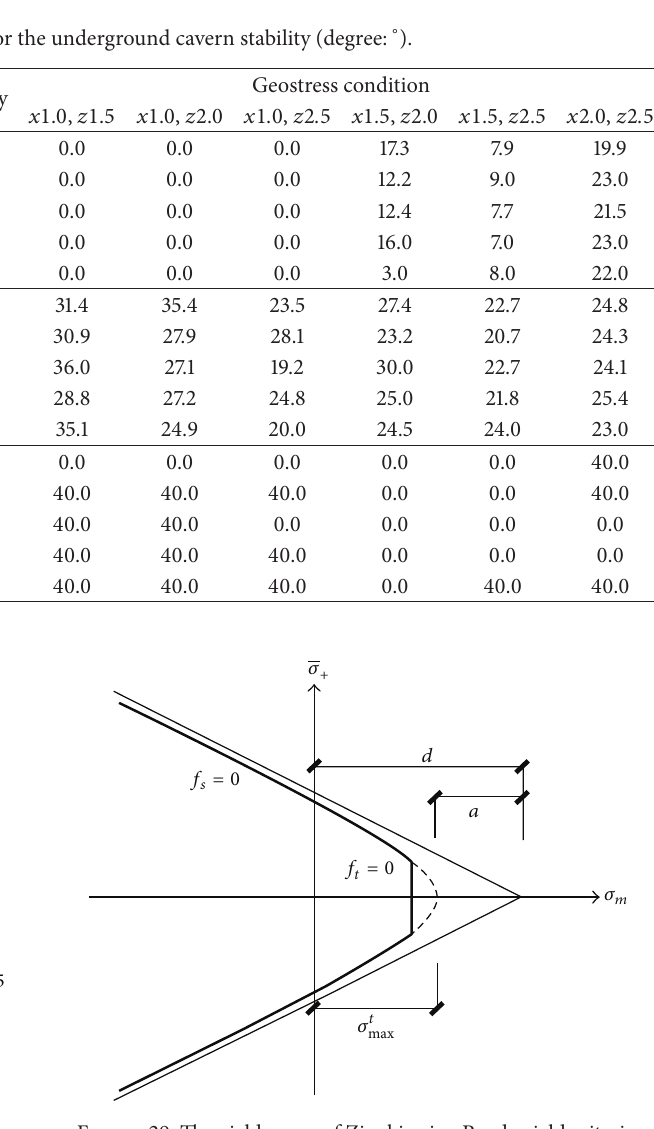
Figure 28: Splitting zone volume versus 𝜃 in case 3 . Figure 29: The yield curve of Zienkiewicz-Pande yield